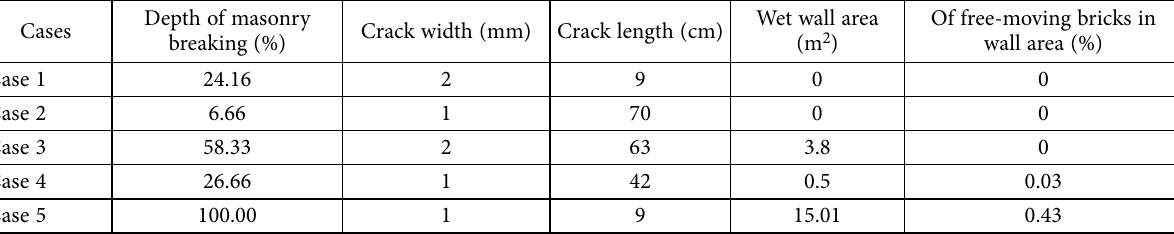
Table 2. Damage size calculations